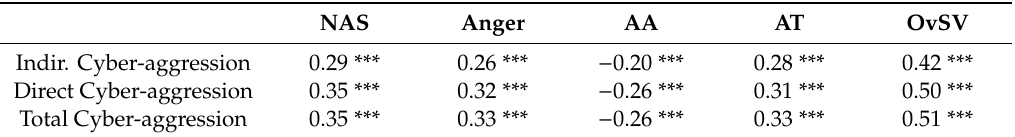
Table 5. Correlations among cyber-aggression, negative attitude towards school, attitude towards institutional authority, attitude towards transgressions, and overt school